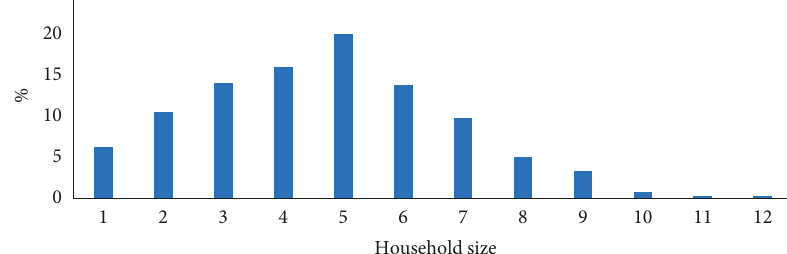
Figure 3: Household skills claimed by respondents.